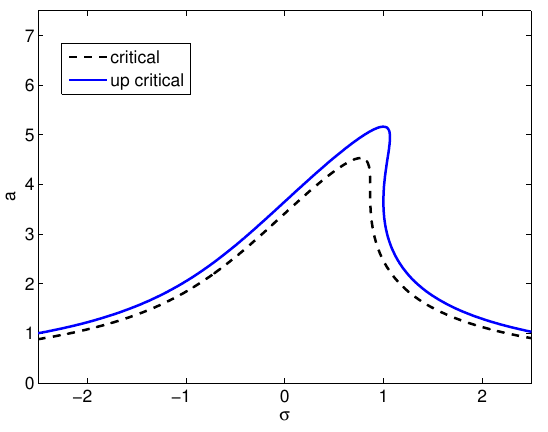
Figure 2. Different frequency-response curves to show the critical forcing amplitude for the Duffing oscillator as calculated using the proposed method (dotted line) and a slightly larger value than this (solid line) extracted from [10]. Data plottedusing g 20 = 0 . 0375 , µ 10 = 1 . Inthiscasethecritical forcing amplitude can be analytically obtained (see